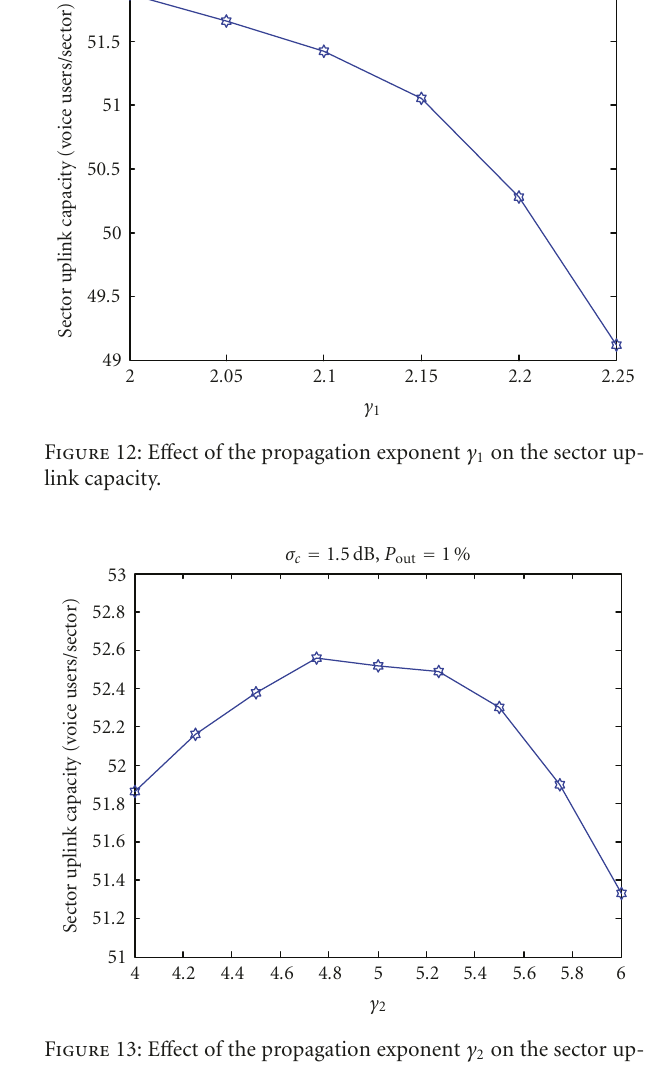
Figure 11: E ff ect of the inter-sites correlation coe ffi cient on the sec- tor uplink capacity.